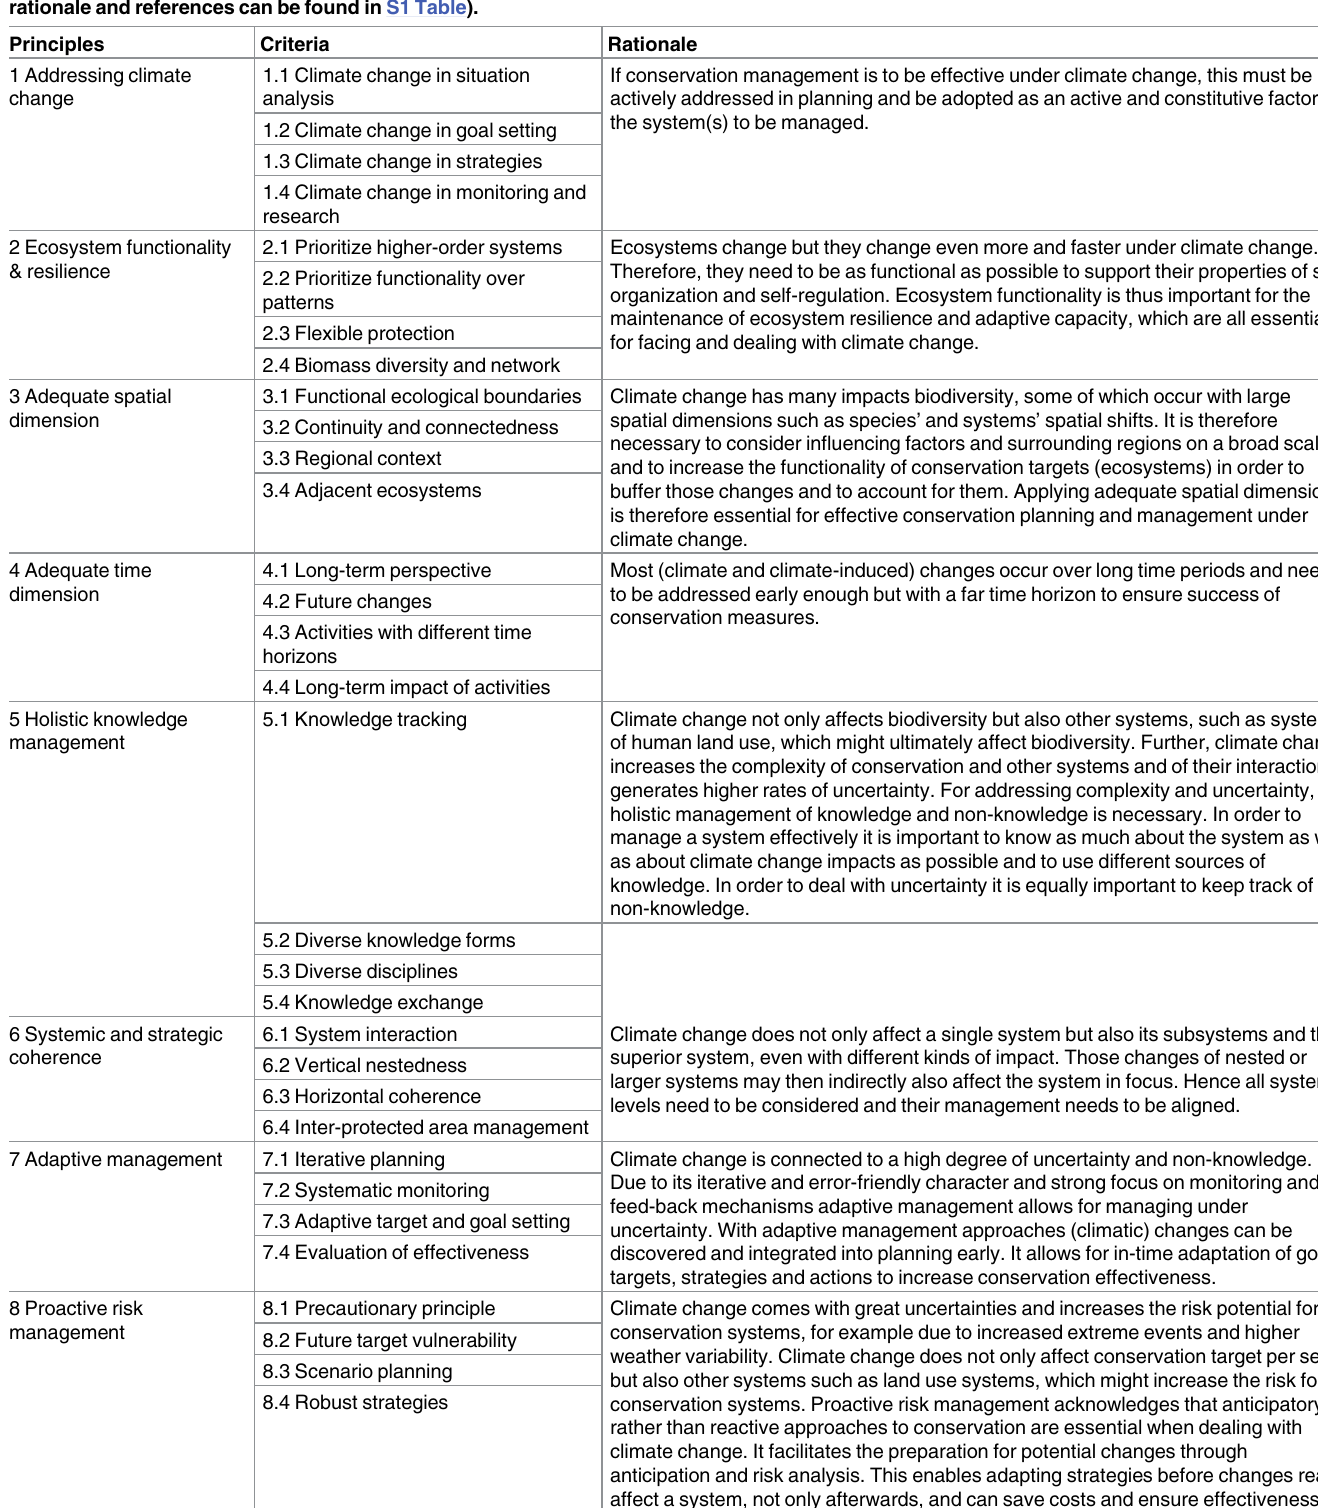
Table 3. Principles and criteria of climate change-robustness (comprehensive list of principles and criteria with full titles, further description, rationale and referencescan be found in S1 Table).